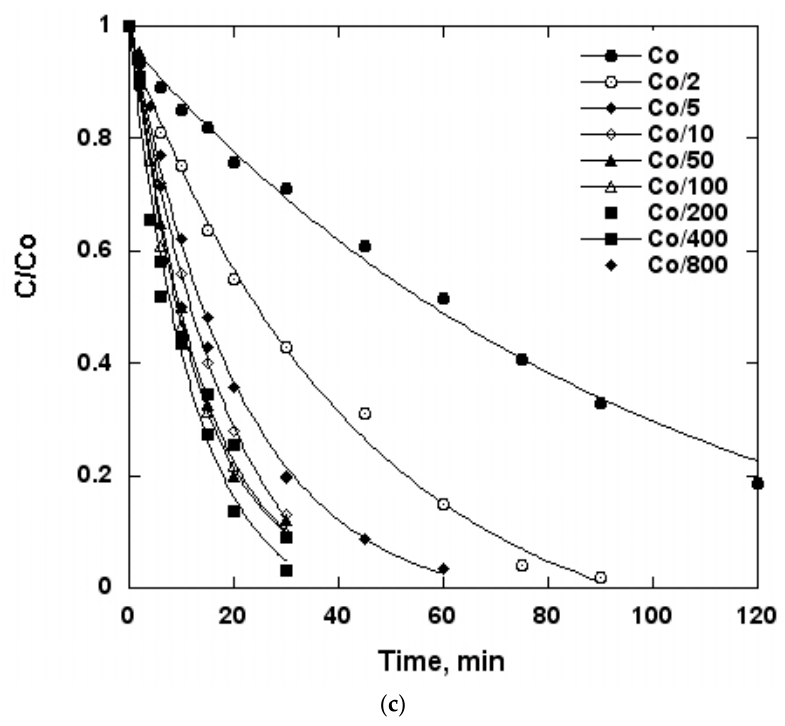
Figure 4. Sonochemical degradation at 352 kHz of benzothiophene (BT) in water (300 mL), temperature = 21 ◦ C ± 1 ◦ C; electrical input = 80 W; ( a ) deionized water C o = 0.67 × 10 − 3 ML; ( b ) natural water C o = 0.71 × 10 − 3 ML; ( c ) sea water C o = 0.95 × 10 − 3 ML.